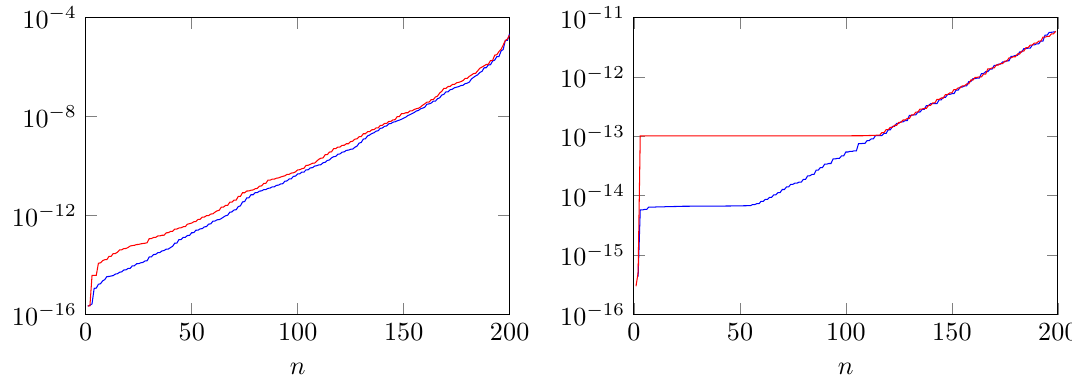
Figure 2: Biorthogonality and projection error, respectively left and right, for a scaled unitary matrix µU ∈ C 200×200 , with µ = 1.1 and same starting vectors. Two-term recurrence relation in blue and four-term recurrence relation in red.